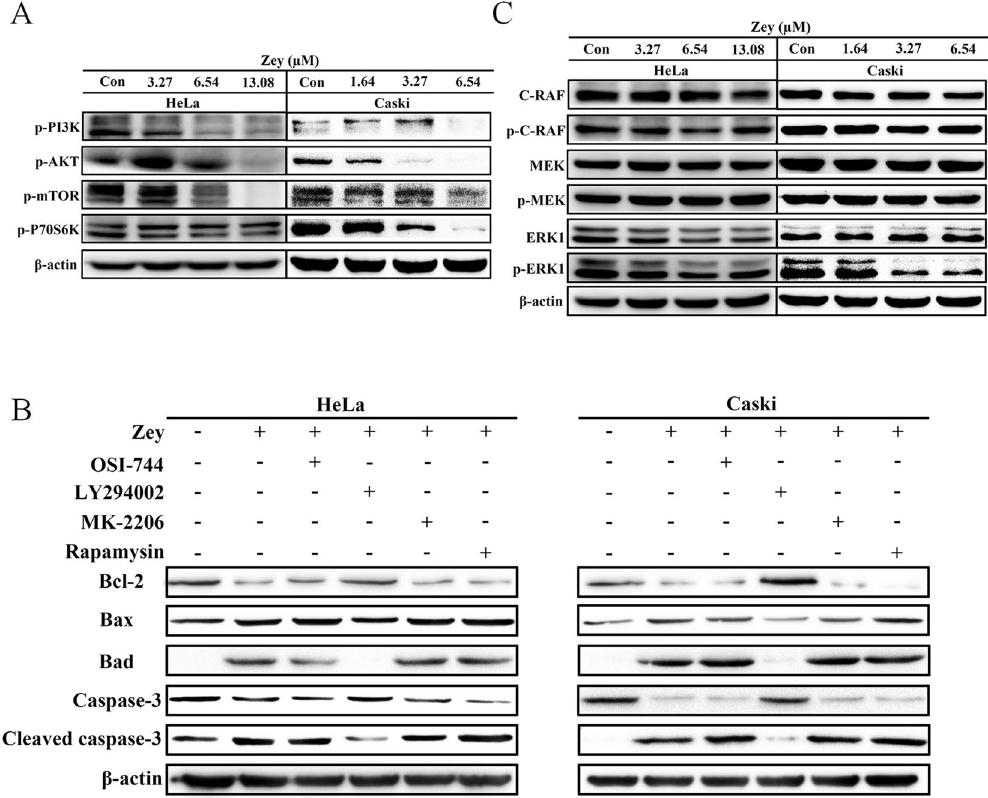
Figure 7. Zey attenuates PI3K/AKT/mTOR and MAPK/ERK pathways in HeLa and CaSki cells. ( A ) Immunoblot analyses of p-PI3K, p-AKT, p-mTOR and p-P70S6K in Zey-treated HeLa and CaSki cells. ( B ) Immunoblot analyses of apoptosis related proteins in HeLa and CaSki cells pretreated with different inhibitors. Cells were pretreated with EGFR inhibitor OSI-744, PI3K inhibitor LY294002, AKT inhibitor MK-2206, and mTOR inhibitor Rapamycin, respectively for 2 h, followed by Zey treatment for 24 h. ( C ) Immunoblot analyses of C-RAF, p-C-RAF, MEK, p-MEK, ERK, and p-ERK in Zey-treated HeLa and CaSki